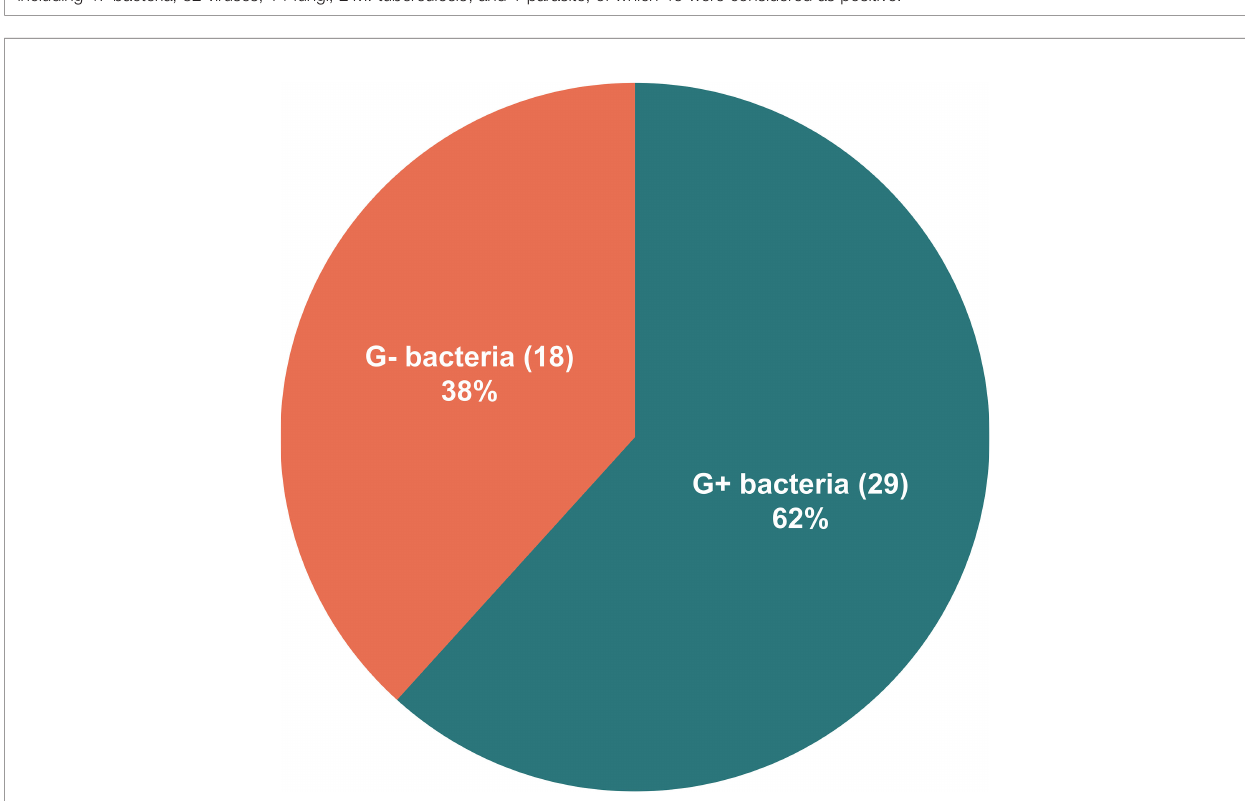
FIGURE 4 | The distribution of Gram-positive bacteria and Gram-negative bacteria detected by metagenomic next-generation sequencing (mNGS). Of the 47 detected bacteria, 29 (62%) were Gram-positive bacteria and 18 (38%) were Gram-negative bacteria.